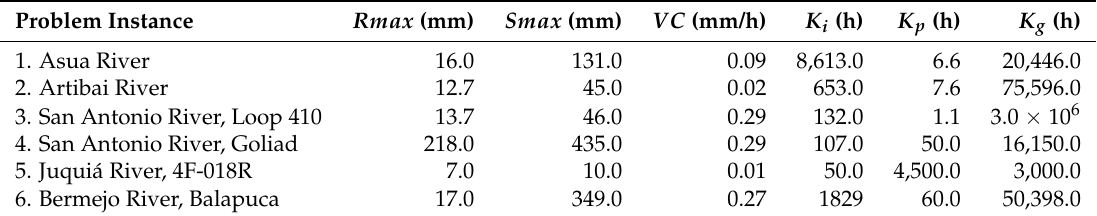
Table 2. Selected solutions from resulting RF approximations after experiments and validations.